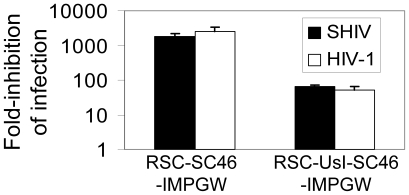
Inhibition of HIV-1 and SHIV in vitro.The anti-HIV vectors were evaluated for SHIV and HIV-1 inhibition using a single-cycle replication assay where MAGI-CCR-5 cells were transduced with the indicated vectors, sorted to over 98% EGFP-positive, then challenged with the indicated viruses and tested for virus replication 48 hours after challenge. The fold-reduction in detected infectious units is reported for each vector relative to the control vector RSC-SMPGW that does not contain an anti-HIV transgene.